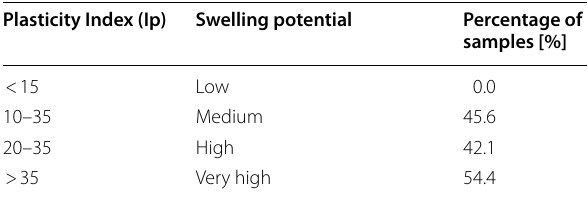
Table 6 Plasticity index and swelling potential (Peck et al. 1974;